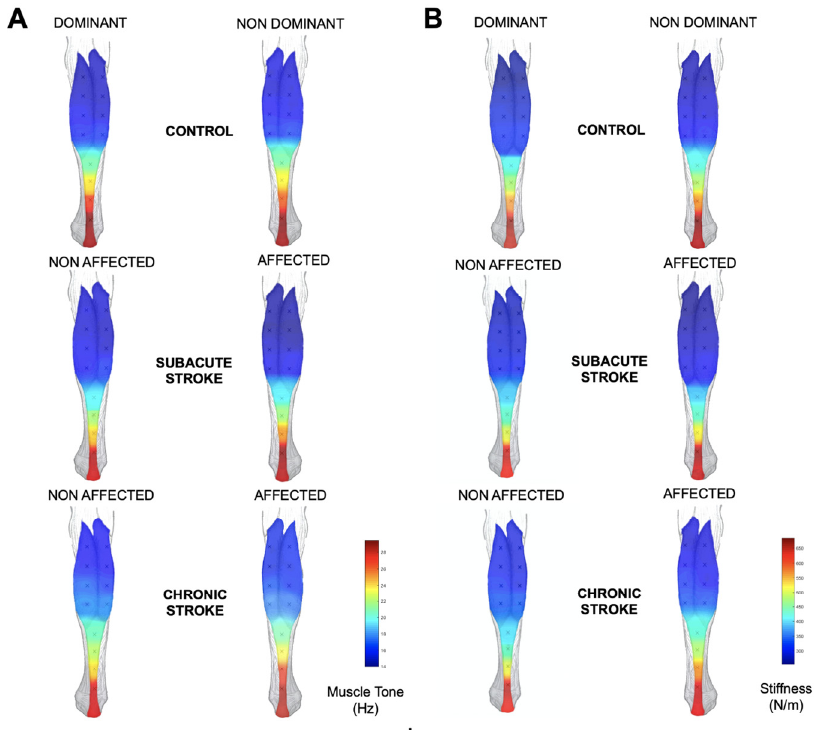
Figure 4. Muscle tone (Hz; A ) and stiffness (N/m; B ) maps based on average values of the assessed locations from the gastrocnemius muscle in individuals with subacute and chronic stroke, and control participants.